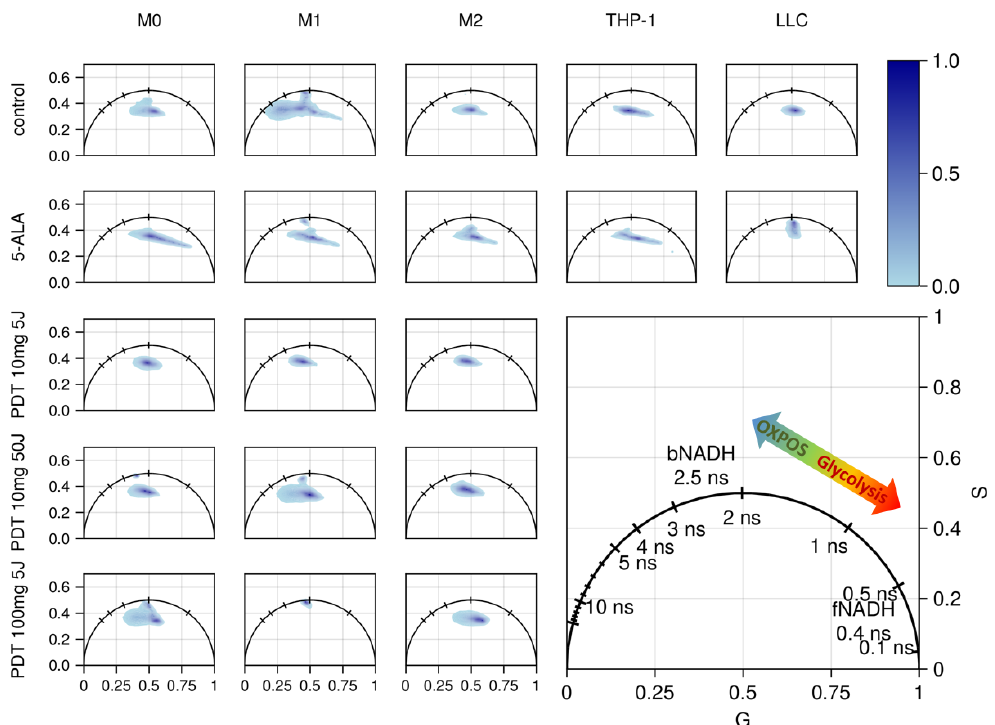
Figure 4. Phasor diagrams for time-resolved fluorescence images of cell culture NADH fluorescence.